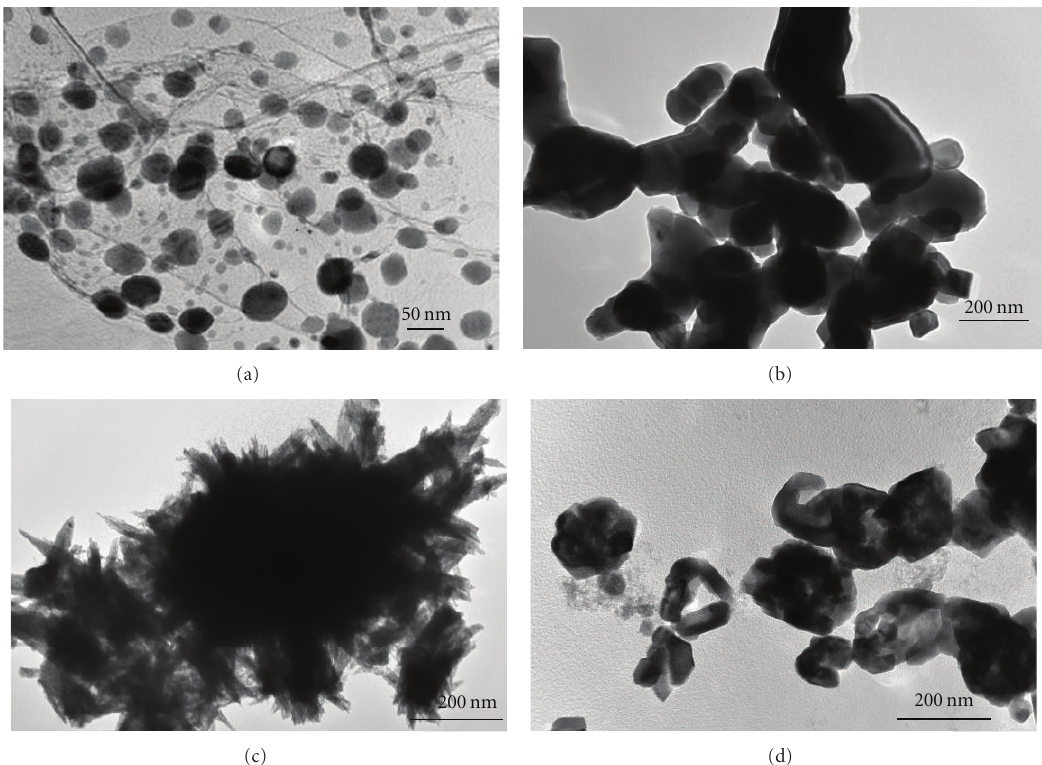
Figure 5: TEM images of iron coated (a) MN-1, (b) MN-2, (c) MN-3, and (d)